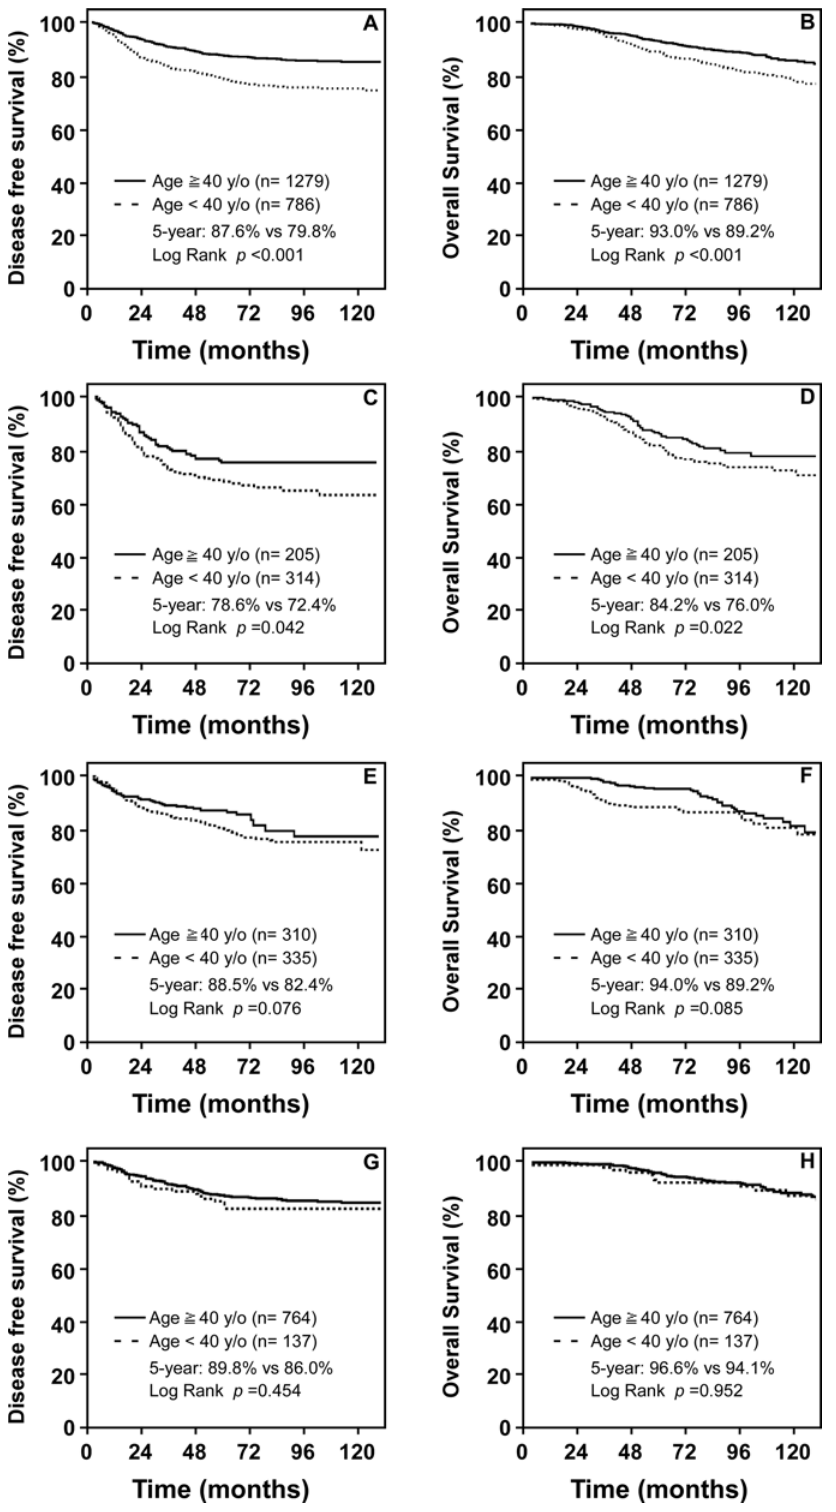
Fig 2. Survival curves by menstrual status after chemotherapy. Groups were divided by the age ( < 40 y/o vs (cid:1) 40 y/o). (A) and (B): DFS and OS for all population; (C) and (D), DFS and OS for patients with normal menses; (E) and (F), DFS and OS for patients with amenorrhoea.